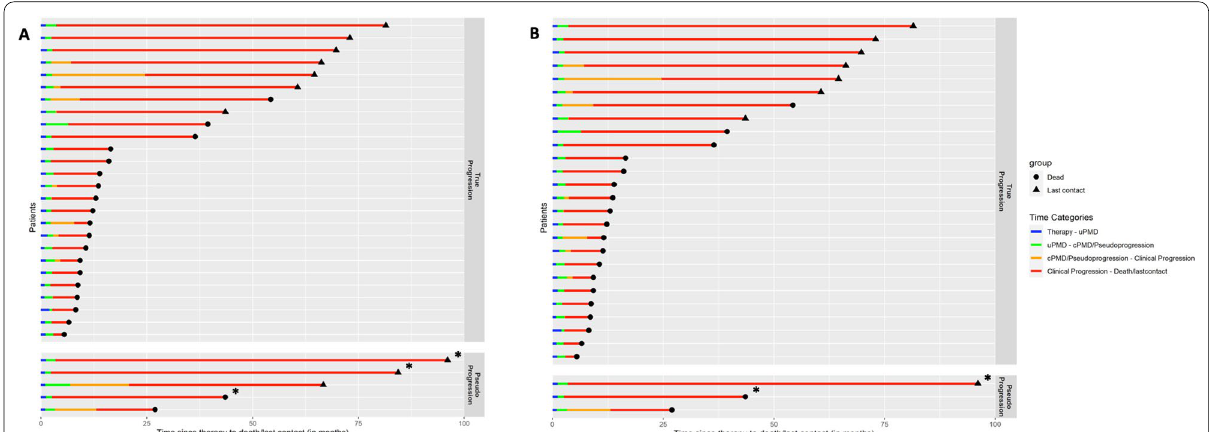
Fig. 4 Plots of events of the studied patient cohort during the follow‑up period after application of EORTC ( n patients) ( b ). The events depicted are: date of therapy commencement, date of uPMD, date of cPMD or remission of pseudoprogression, date of clinical progression, and date of death or last contact. For both sets of criteria, patients were dichotomized in those showing true progression/ cPMD (upper part of the figures), and those showing pseudoprogression (lower part of the figures). *These patients did not show clinical disease progression according to the evaluation of the dermato‑oncologists. In these cases, the red part of the lines of events corresponds to the time interval between remission of pseudoprogression in PET/CT and date of death or last